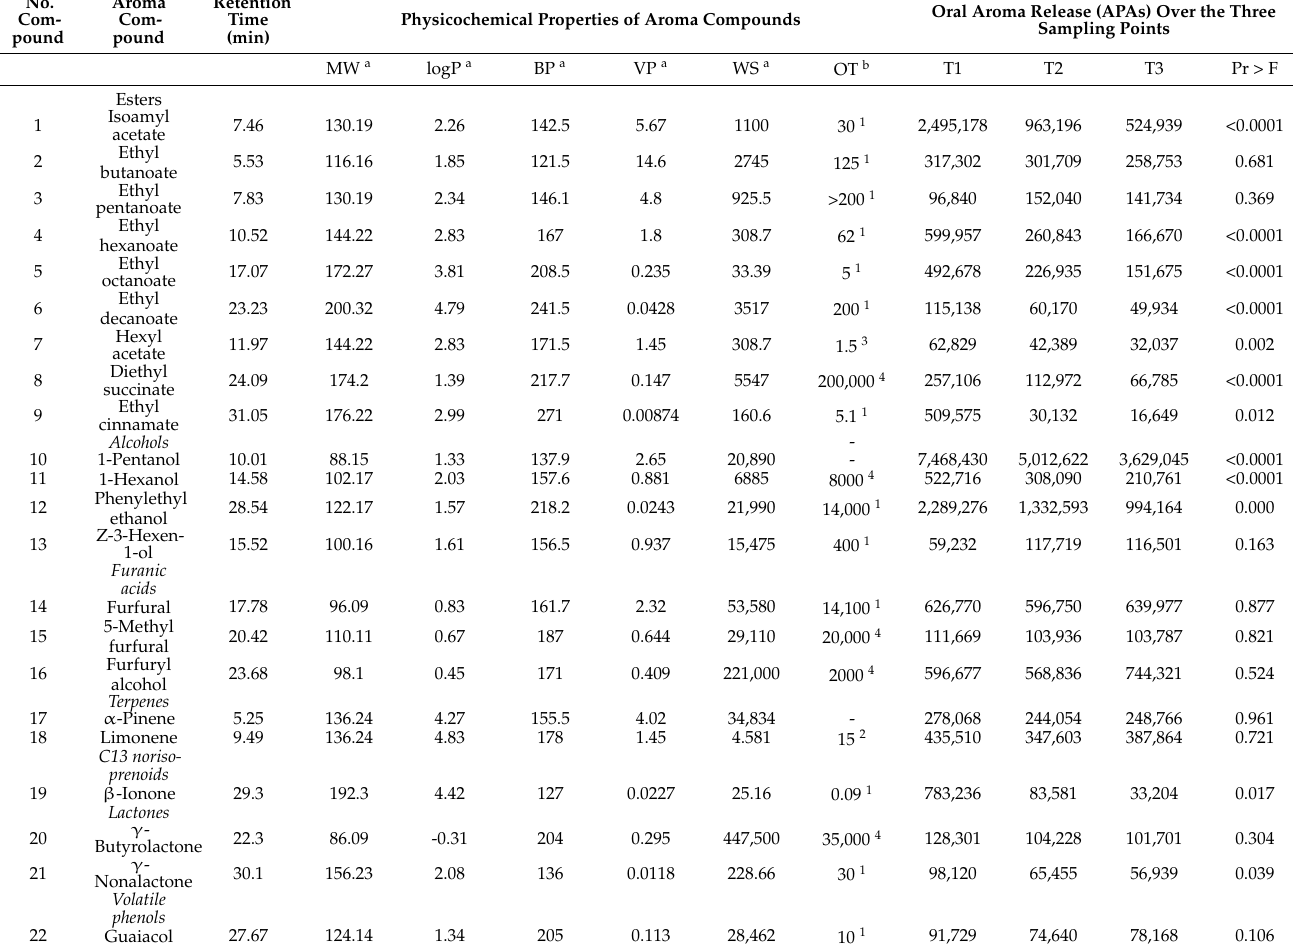
Table 1. Retention times, physicochemical properties, and oral release (average values of three repetitions of absolute peak areas) of the 22 aroma compounds detected in the mouth at three different sampling points: 0 (T1), 60 (T2), and 120 (T3) seconds after wine expectoration. The table also shows the results from one-way ANOVA to check for significant differences ( p < 0.05) between the three extraction